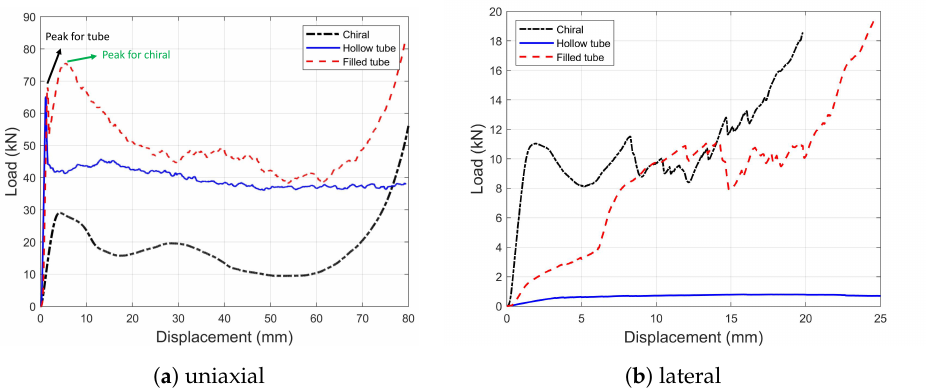
Figure 11. Load–displacement curves of the lateral and uniaxial crush of chiral structures, hollow tubes and chiral-filled tubes. Table 8. Average crush properties of the chiral structure, hollow tube and filled tube under uniaxial loading.